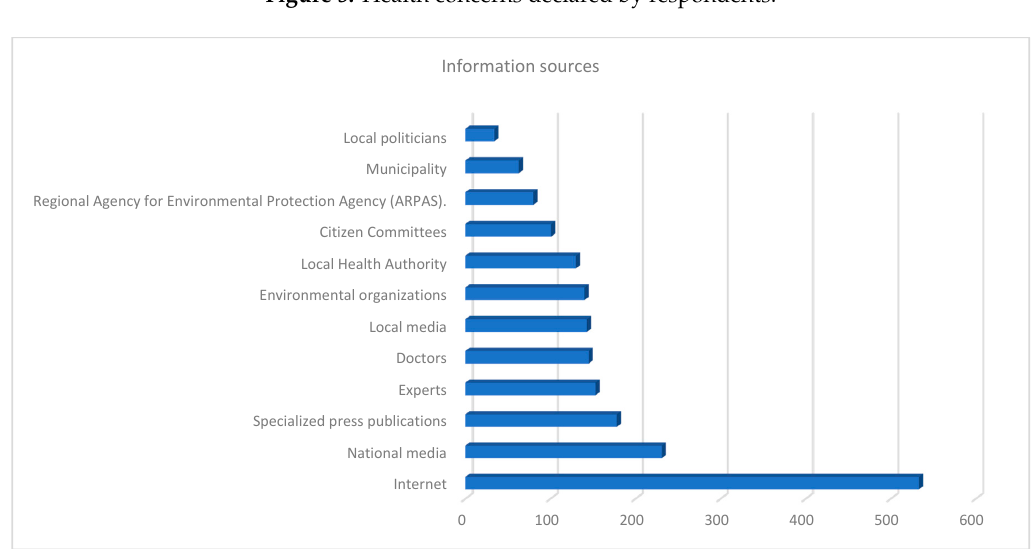
Figure 6. Main sources of information.